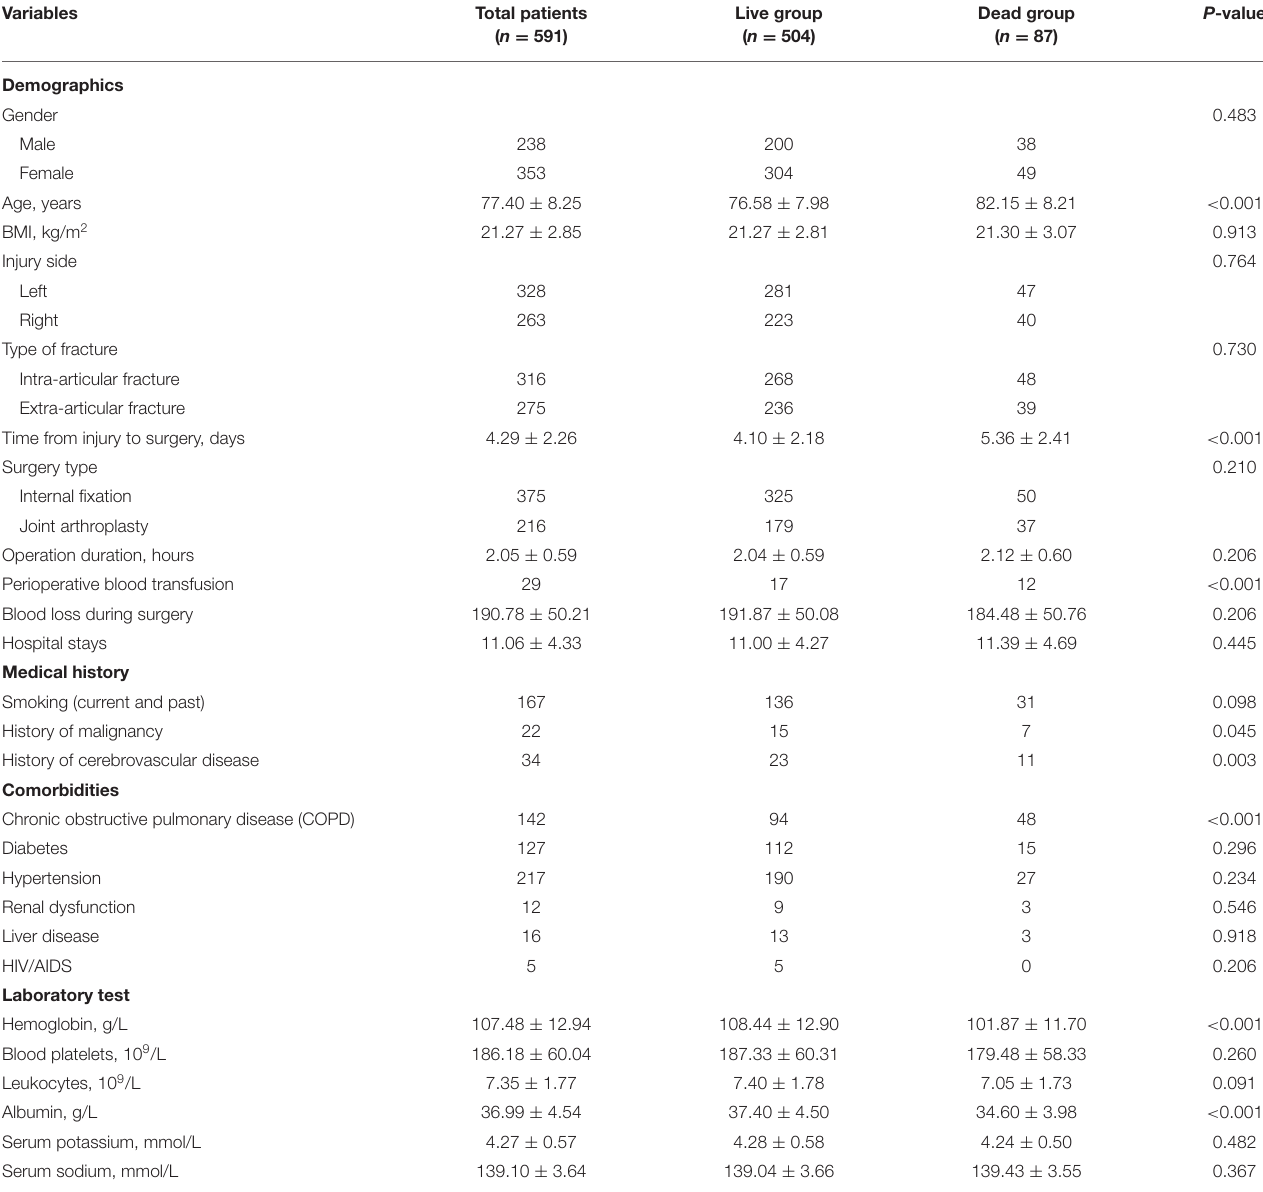
TABLE 1 | The baseline characteristics of all enrolled patients.